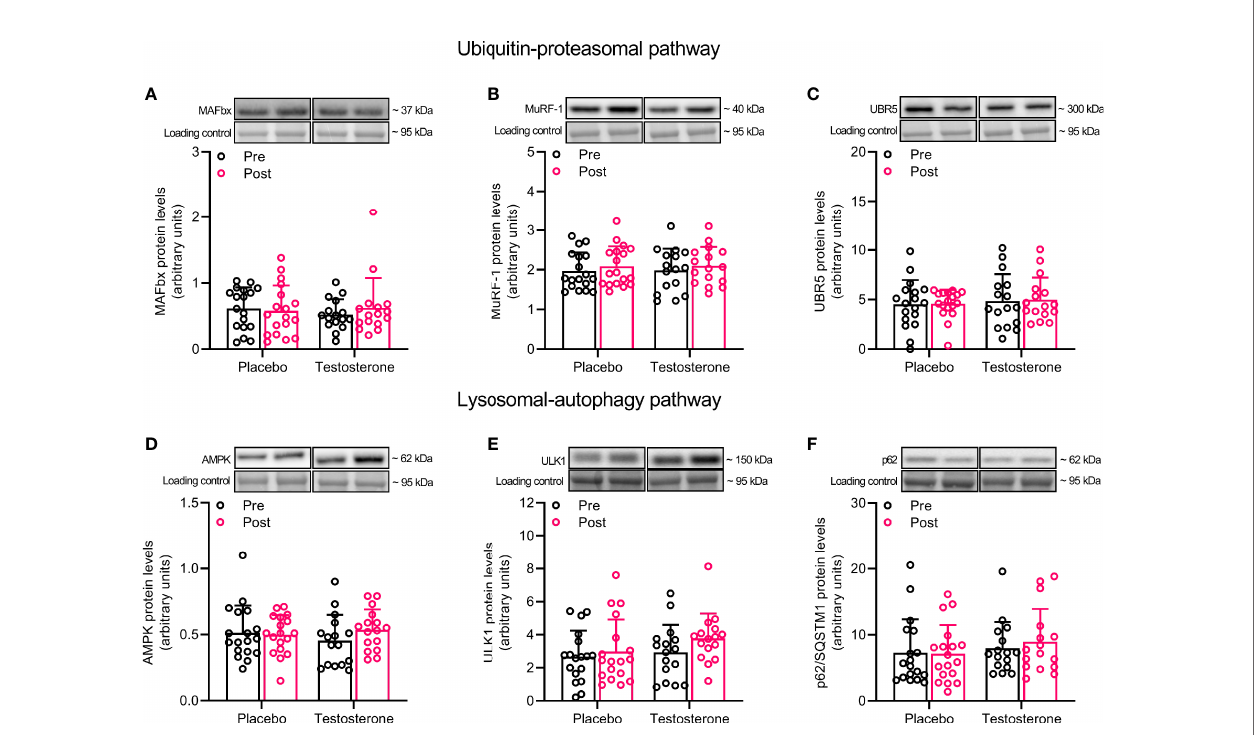
FIGURE 2 | Protein levels of MAFbx (A) , MuRF-1 (B) , UBR5 (C) , AMPK (D) , ULK1 (E) and p62 (F) before (black dots) and after the intervention (red dots). Representative blots for each individual protein target are shown above each graph. Loading control is represented by a band at ~ 95 kDa from the corresponding total protein stain (Memcode ™ ). The values presented are means ± SD and individual data points from 18 and 16 individuals (DF 32) in the placebo group and T group,